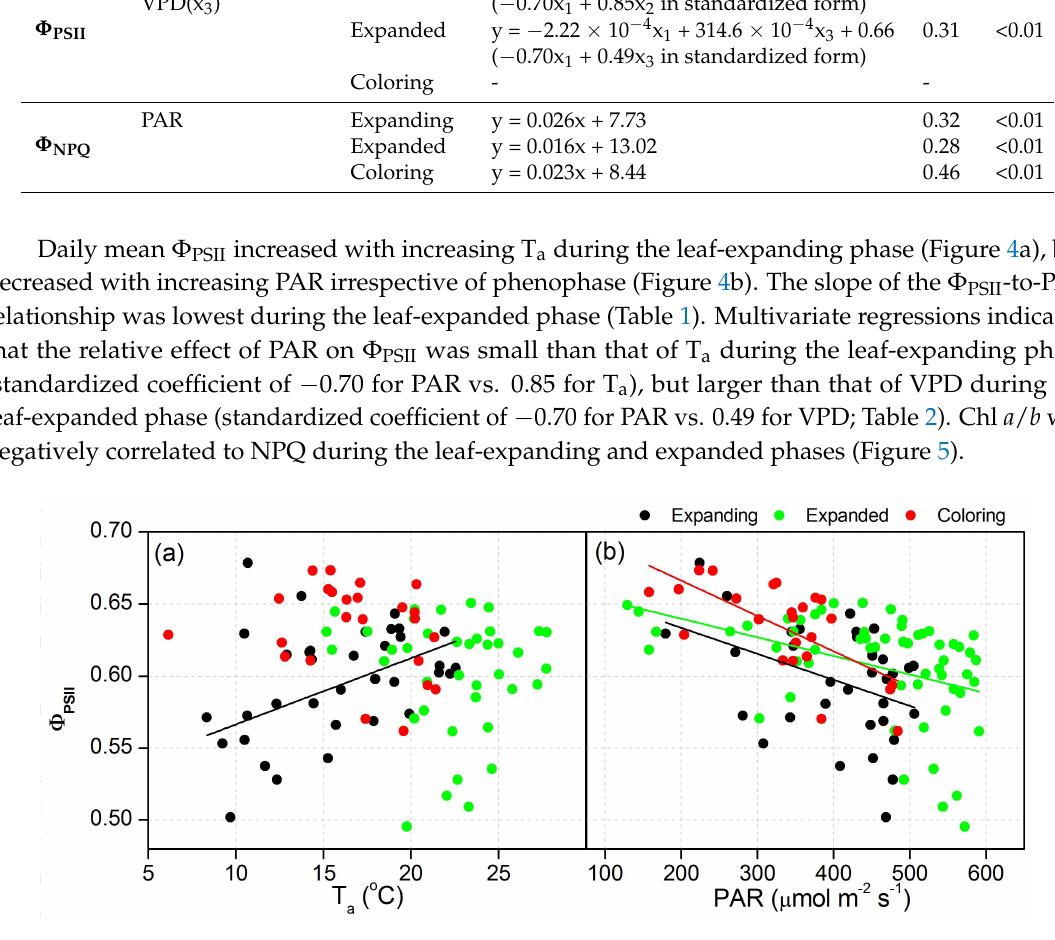
Figure 4. Relationship between daily mean effective quantum yield of PSII photochemistry ( Φ PSII ), daily mean air temperature (T a , ( a )), and incident photosynthetically active radiation (PAR, ( b )) during each phenophase during the 2014 growing season. Black, green, and red colored circles and lines coincide with values and fitting functions (Table 1) for the leaf-expanding, expanded, and coloring phases, respectively. Data from rainy days were excluded from the